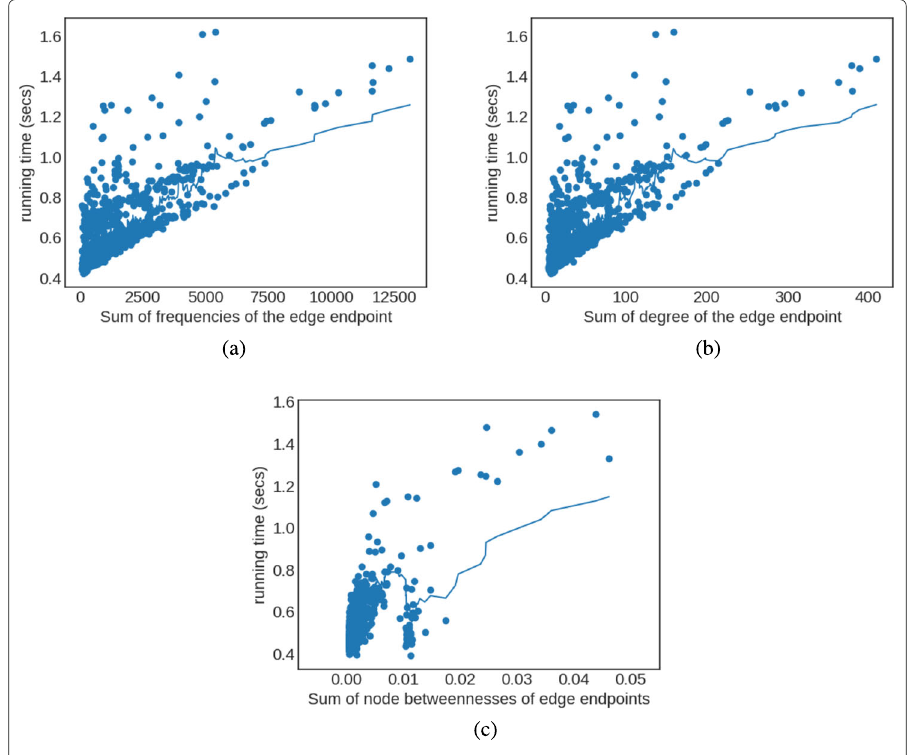
Fig. 6 Dependency of E VO NRL running time on importance of added edge as described by various metrics on PPI Network. a frequency of the new edge endpoints, b node degree of the new edge endpoints, and c node betweenness of the new edge